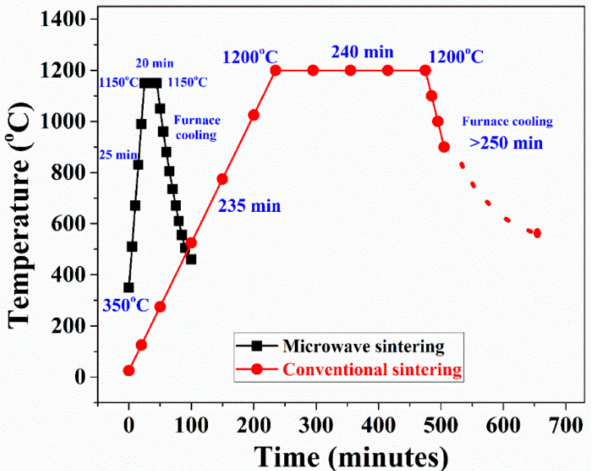
Figure 1. Schematic representation of microwave and conventional sintering of PLZT 8 / 60 / 40 ceramics at 1150 ◦ C and 1200 ◦ C, respectively